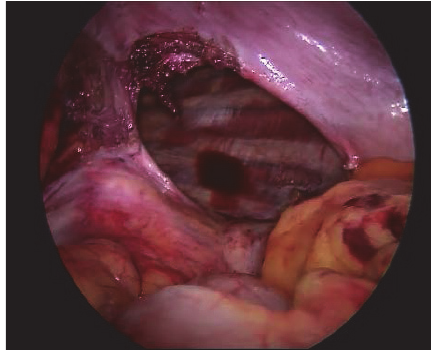
Figure 1: Large Bochdalek hernia on left side.